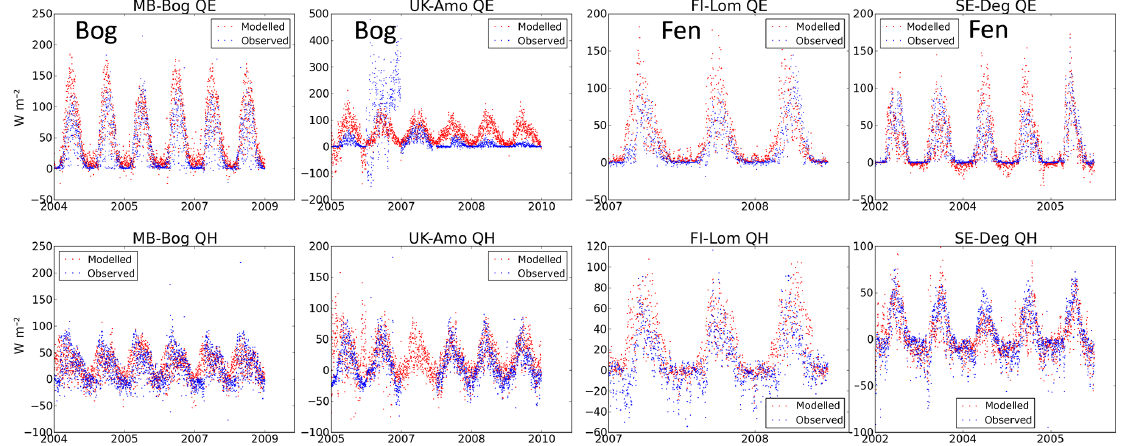
Figure 6. Simulated and observed daily average latent heat flux QE (Wm − 2 ) and sensible heat flux QH (Wm − 2 ) in two bogs (MB-Bog and UK-Amo) and two fens (FI-Lom and SE-Deg).